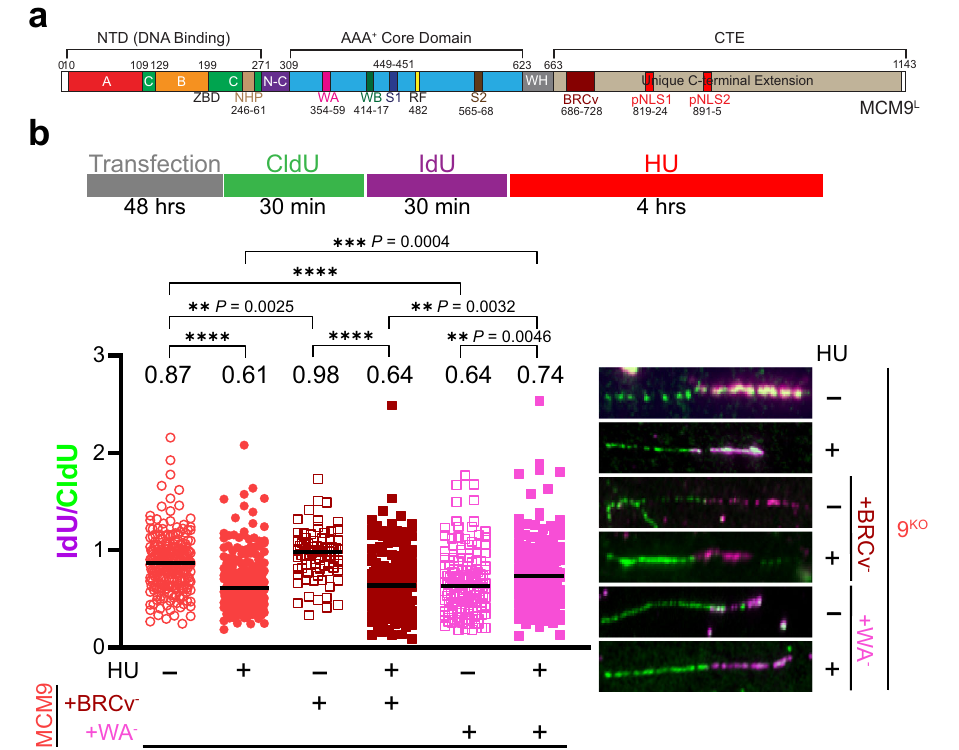
Fig. 7 | The MCM9-BRCv motif is in fl uential in stabilizing HU-stalled forks, but the ATPase activity is necessary for normal fork progression. a Schematic of MCM9 showing domains and individual motifs. b 9 KO cells ( ○ ) were transfected pEGFPC2-MCM9(FR687/8AA) (BRCv − ) ( , brown) or pEGFPC2-MCM9(K358A) (WA − )( ,pink)for48hprior.CellswerethensequentiallyincubatedwithCldUandIdU for the indicated time intervalsor followed by 2mM HU for 4h ( ● or ■ ). DNA was